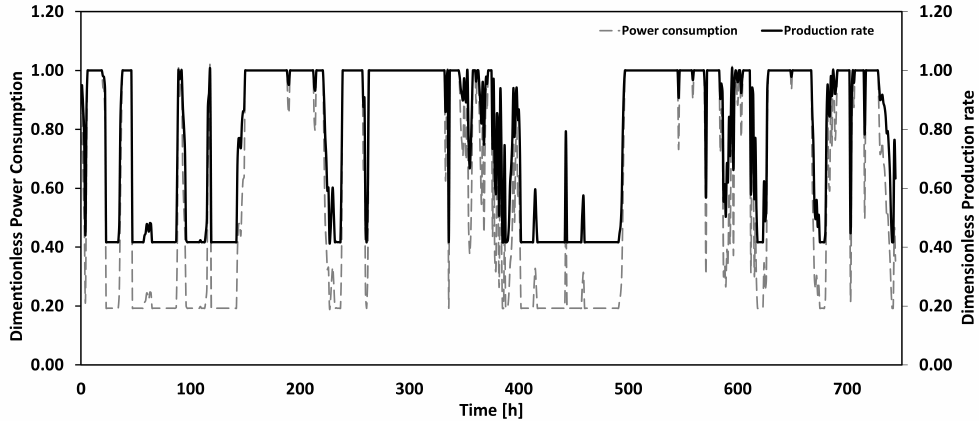
Figure 5. The production rate time series data together with the power consumption of the